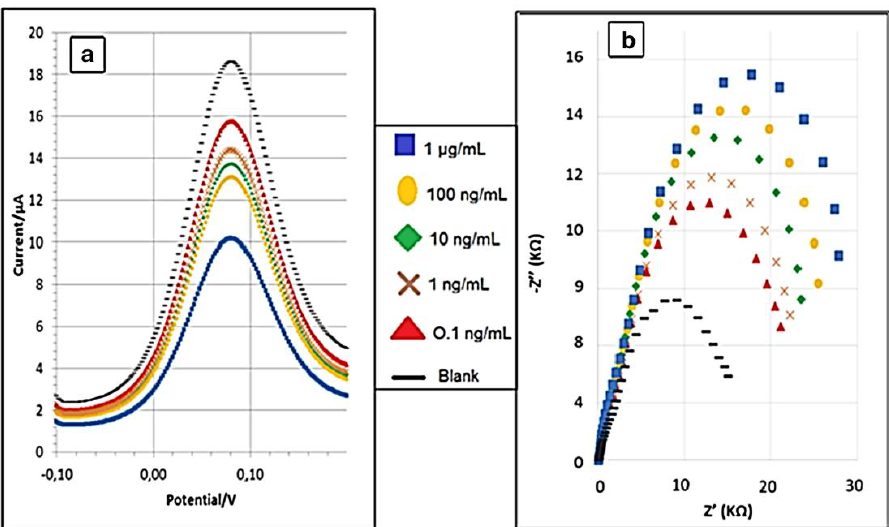
Figure 6. Differential pulse voltammograms of different concentrations of creatinine solutions ( a ) and Nyquist plots of different concentrations of creatinine solutions ( b ) in 5.0 mM[Fe (CN)6] 3− and 5.0 mM [Fe (CN) 6] 4− in PBS buffer at pH 7.4. Z’ and Z’’ in Figure 6b represent the real and the imaginary part, respectively, of the impedance. Reprinted from [43].